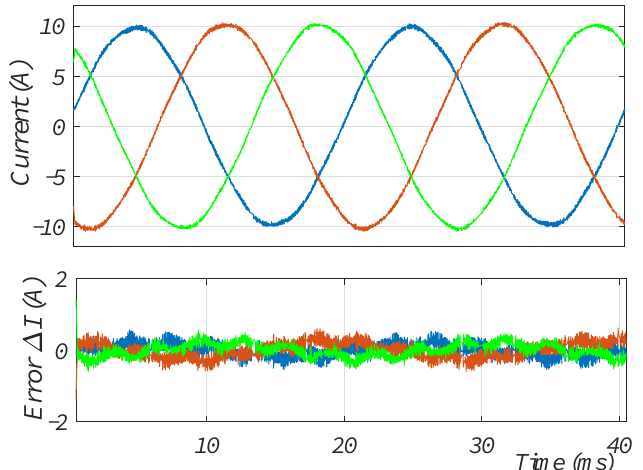
Figure 5. Simulation results of ssNN-PSO-based predictive control: Output current for specified resistive load and filter inductance. (Red line: i a , Green line: i b , Blue line: i c